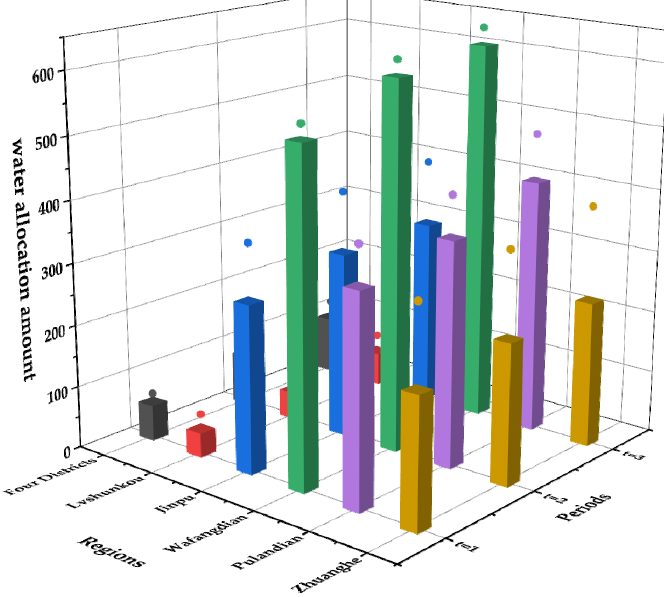
Figure 6. Reused water resource allocations for environment.